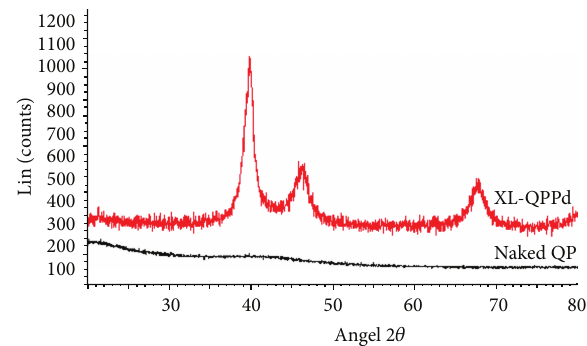
Figure 1: XRD patterns of the naked QuadraPure and the XL-QPPd